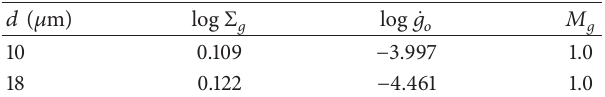
Table 5: The constitutive parameters for GBS ( ̇𝑔 element) deter- mined from the load relaxation test result of 8090 Al–Li alloy at 530 ∘